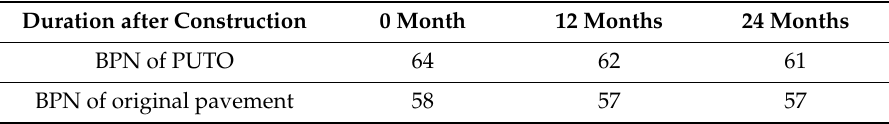
Figure 22. BPNs at different test points. Table 8. The BPN value of the PUTO and original pavement.